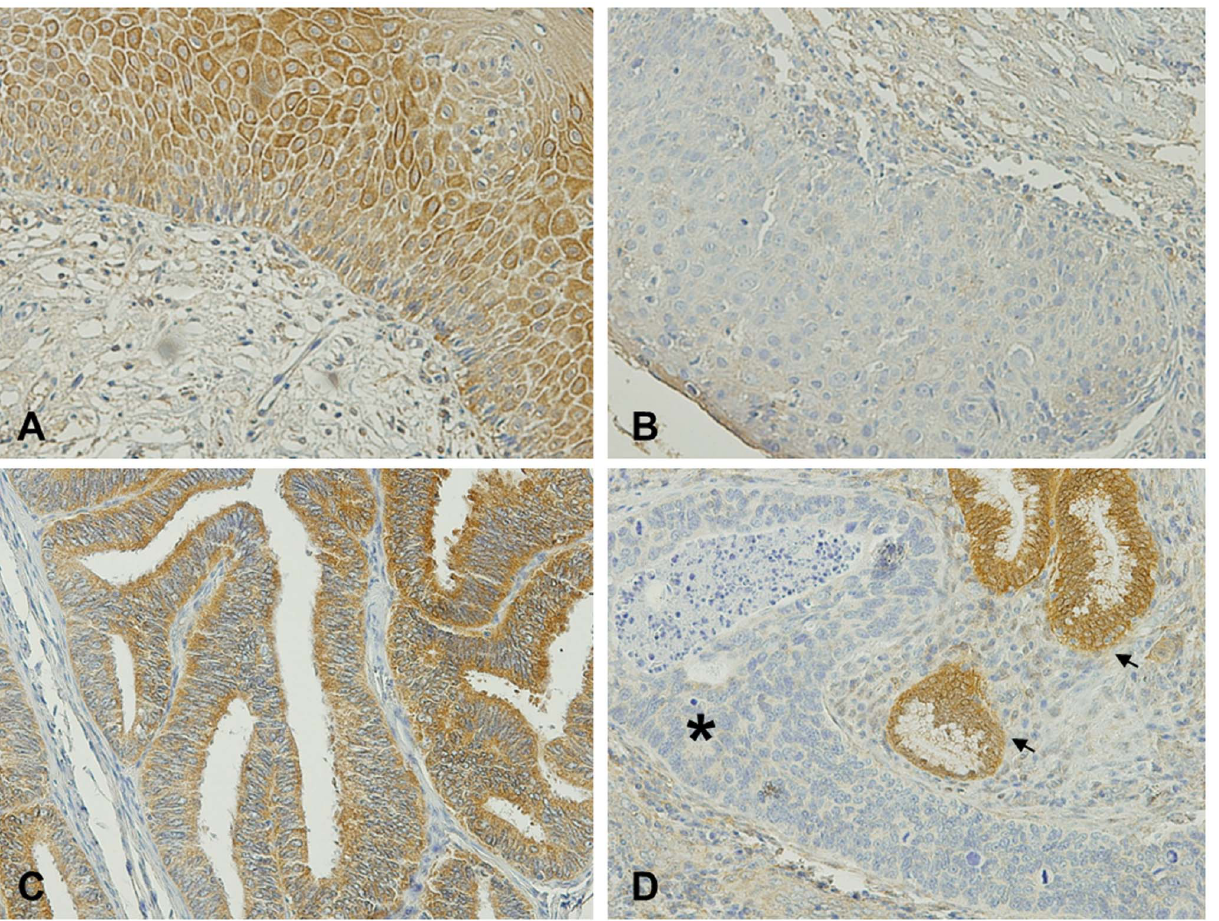
Figure 1. Immunohistochemistry analysis of RKIP in cervical tissues. A) Positive expression in a cervicitis. B) High-grade squamous intraepithelial lesion with negative expression. C) Adenocarcinoma tissue depicting positive expression. D) Negative adenocarcinoma (*) with adjacent normal cells (arrow) depicting positive staining. All the pictures were taken with at 200 6 magnification.